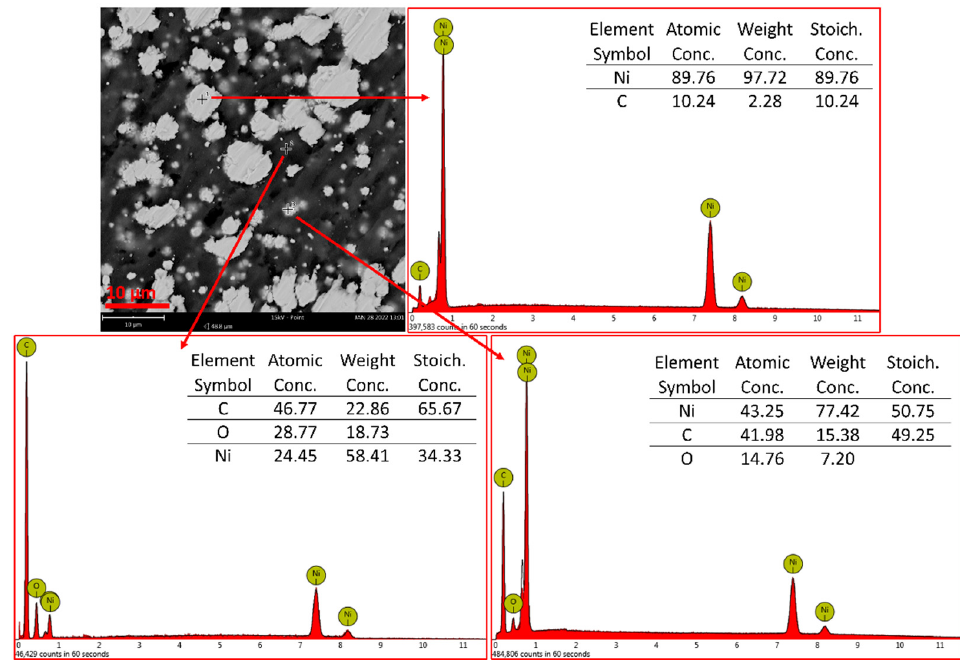
Figure 7. SEM image and representative EDS spectra with element concentrations for composite filament cross-section performed for different points on the sample (PVB-Ni 25%).